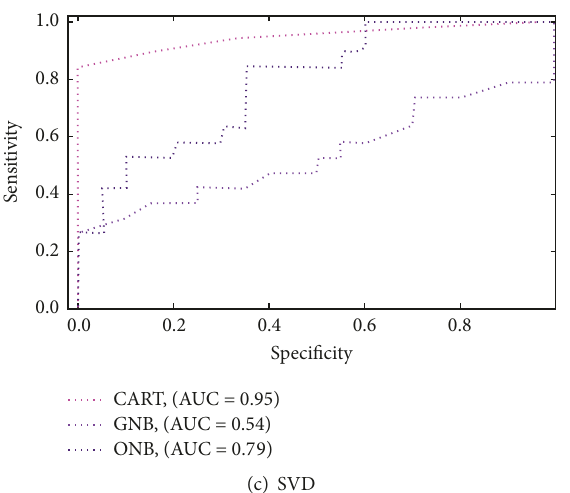
Figure 12: ROC curves for classification using the CART, Gaussian, and optimized Naive-Bayes with ICA, PCA, and SVD data reduction techniques.